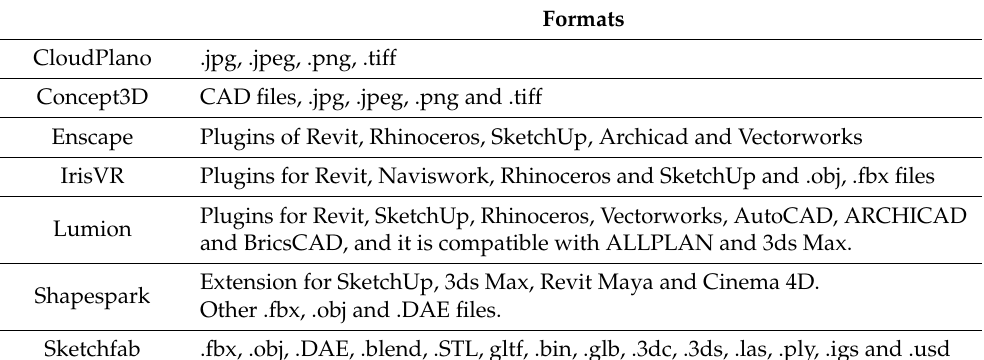
Table 5. Selection of digital platforms according to the previously mentioned